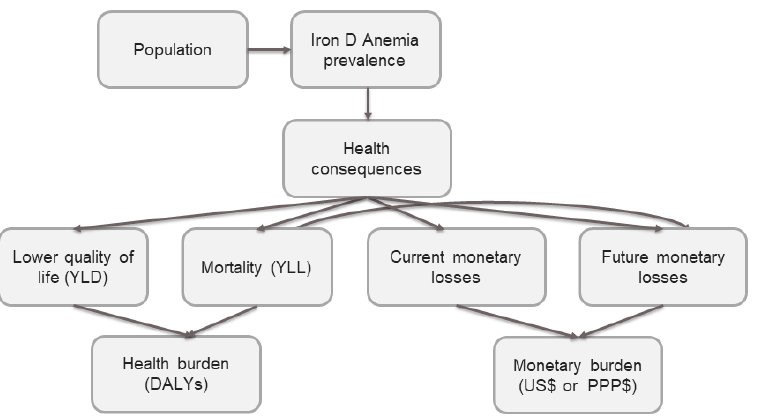
Figure 1. Structure of the simulation model.